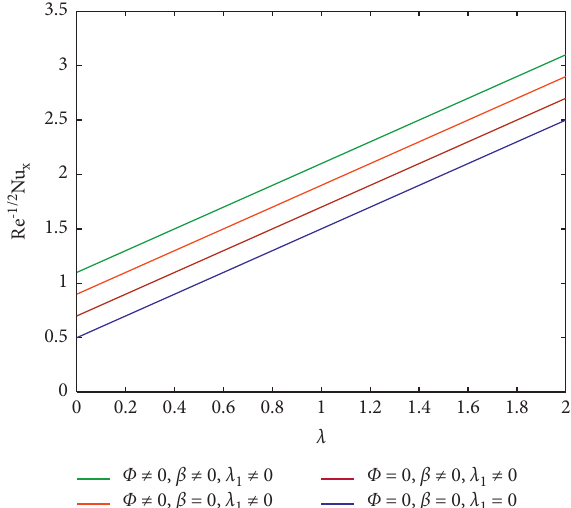
Figure 7: Different cases comparison of heat transfer rate in the flow of MgZn